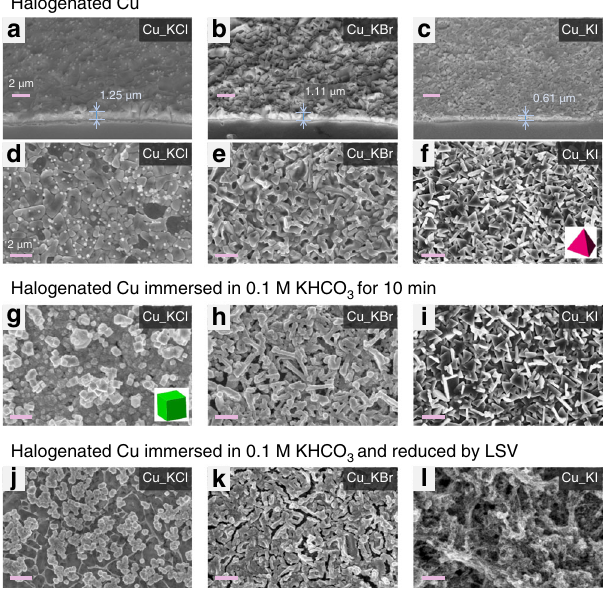
Fig. 3 Morphology of halogenated Cu-foil electrodes. SEM images of halogenated Cu foils: a – f as-prepared; g – i after immersion in 0.1 M KHCO 3 for 10 min; j – l after reduction by LSV in the potential range from OCP to − 1.8 V in CO – c Cross-sectional images taken at 2 -saturated 0.1 M KHCO 3 . a a tilt angle of 45° to reveal the thickness of halogenated Cu. d – l Plan-view images. Anodic halogenation of Cu was performed for 50 s in 0.1 M KCl at 1.1 V ( a , d , g , j ); in 0.1 M KBr at 0.18 V ( b , e , h , k ); in 0.1 M KI at − 0.2 V ( c , f , i , l ). All voltages are reported vs. Ag/AgCl. Scale bars: 2 μ